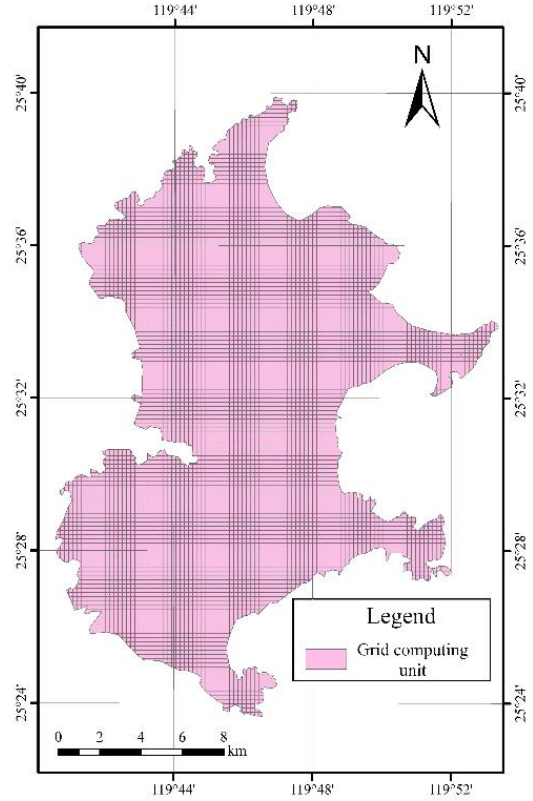
Figure 4. Research area grid subdivision diagram.